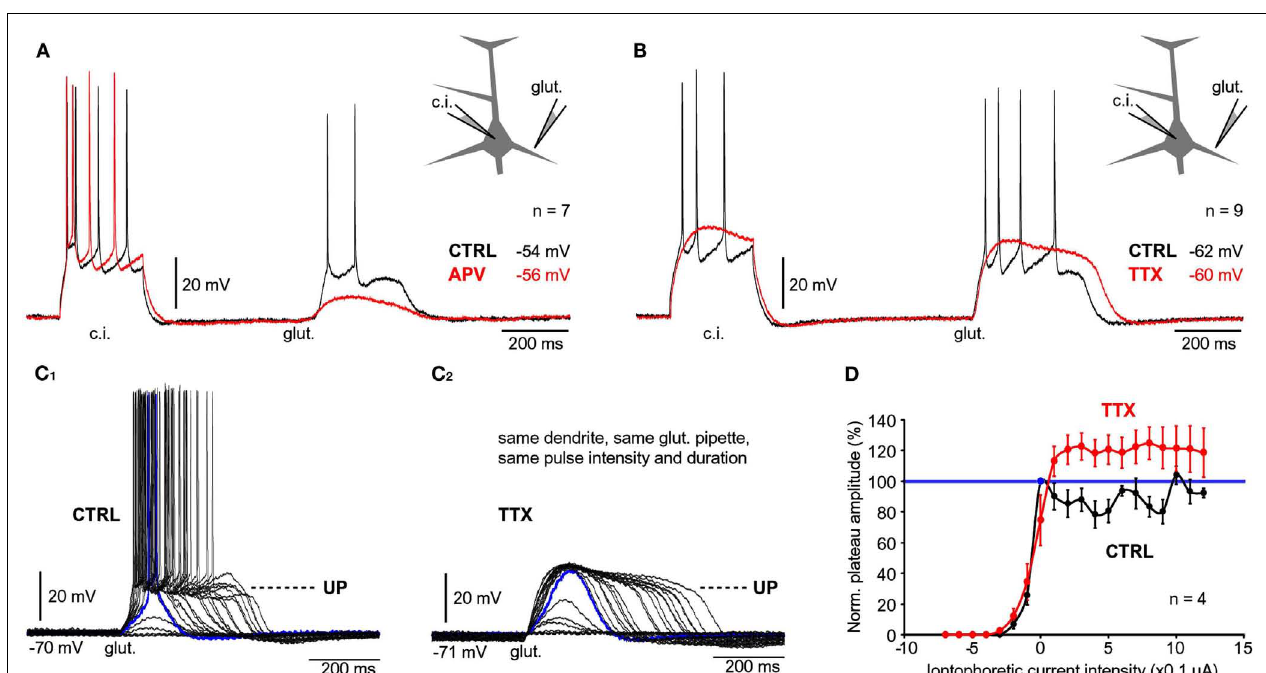
was gradually increased (fixed increments), while somatic depolarizations were recorded via whole-cell electrode. (C 2 ) Same measurements in (C 1 ) , were repeated in the presence ofTTX. (D) Amplitude of depolarization is plotted against the intensity of glutamate stimulus before (CTRL, black) and after introduction ofTTX (red). All values are normalized against the amplitude of the first plateau in the sequence (blue data point), corresponding to the blue trace in (C 1 )